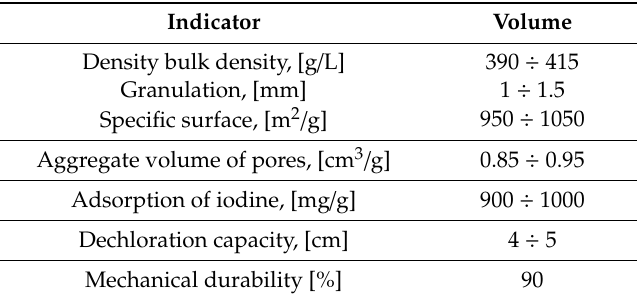
Table 1. Characteristics of activated carbon